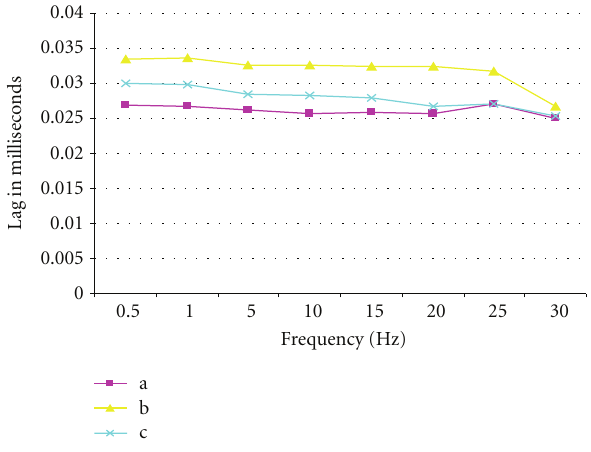
Figure 26: Progressive drops in response time with increasing fre- quency. The legend (a, b, c) refers to the environmental temperature as shown in Figure 27.